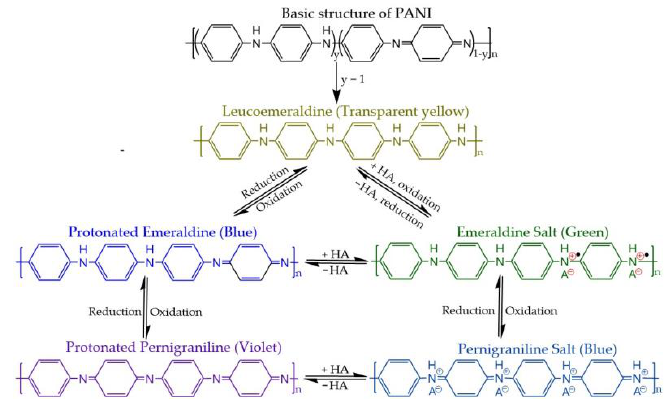
Figure 10. The different redox/protonation states and colors of PANI.